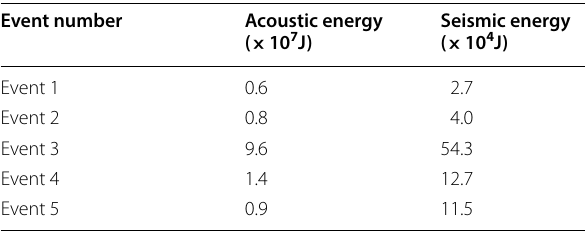
Table 3 Estimated acoustic and seismic energies based on recorded